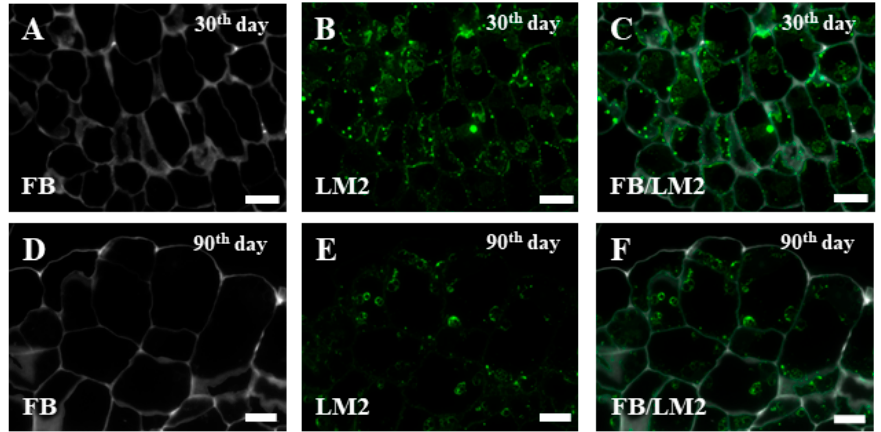
Figure S1. Immunolocalisation of JIM13 ( A – F ) and JIM16 ( G – L ) in B. distachyon callus. ( A – C , G – I ) 30th day of cultivation; ( D – F , J – L ) 90th day of cultivation. FB: fluorescent brightener. Scale bars, 10 μ m.